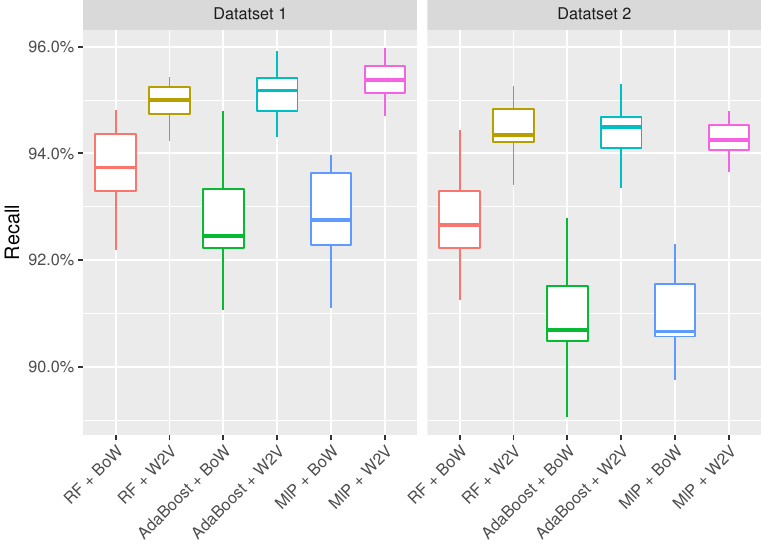
Figure 7. Cross validation values of the recall index for the prediction of the IVA codes (received